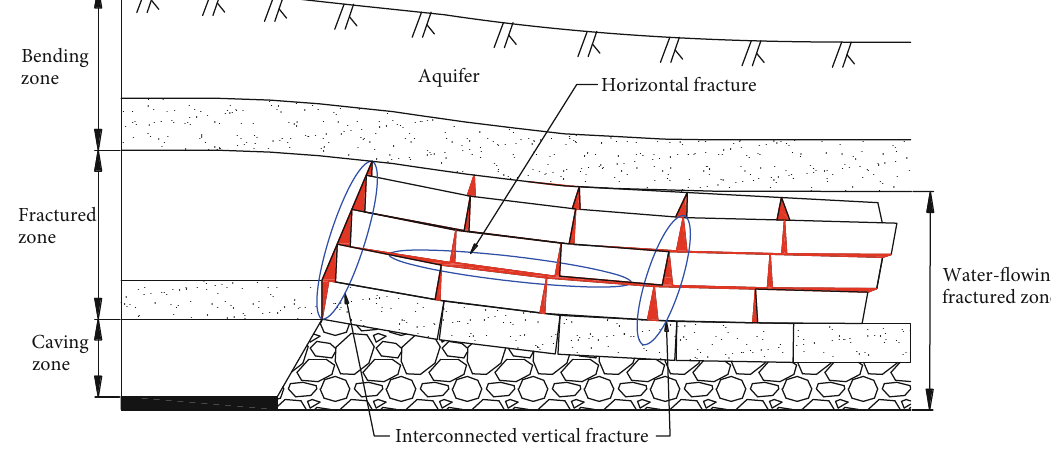
Figure 1: Distribution diagram of overburden fracture after coal seam